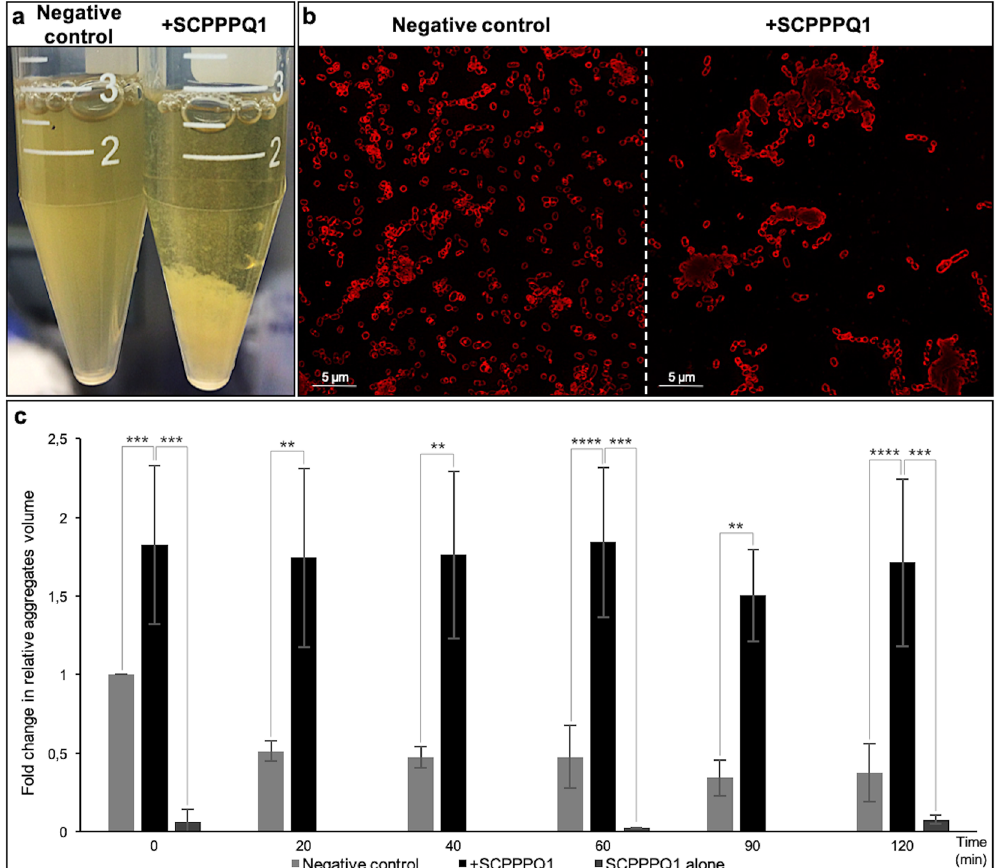
Figure 4. Effect of SCPPPQ1 on formation of P. gingivalis bacterial aggregates. ( a ) Visual inspection of bacterial cultures in test tubes from the negative control (left) and + SCPPPQ1 treated (right) samples at 20 min. A representative image from six different experiments is shown. ( b ) Super-resolution fluorescence images of bacteria (membrane stained in red with FM 4–64 dye) from the negative control (left) and + SCPPPQ1 treated (right) samples at 20 min. Images are representative from five different experiments. ( c ) FACS results of the fold change in relative aggregates volume over time normalized on the negative control at 0 min. Data are represented as mean ± standard error of mean ( n = 4). Significance was determined by two-tailed Student’s t test analysis (** p < 0.01; *** p < 0.001; **** p <